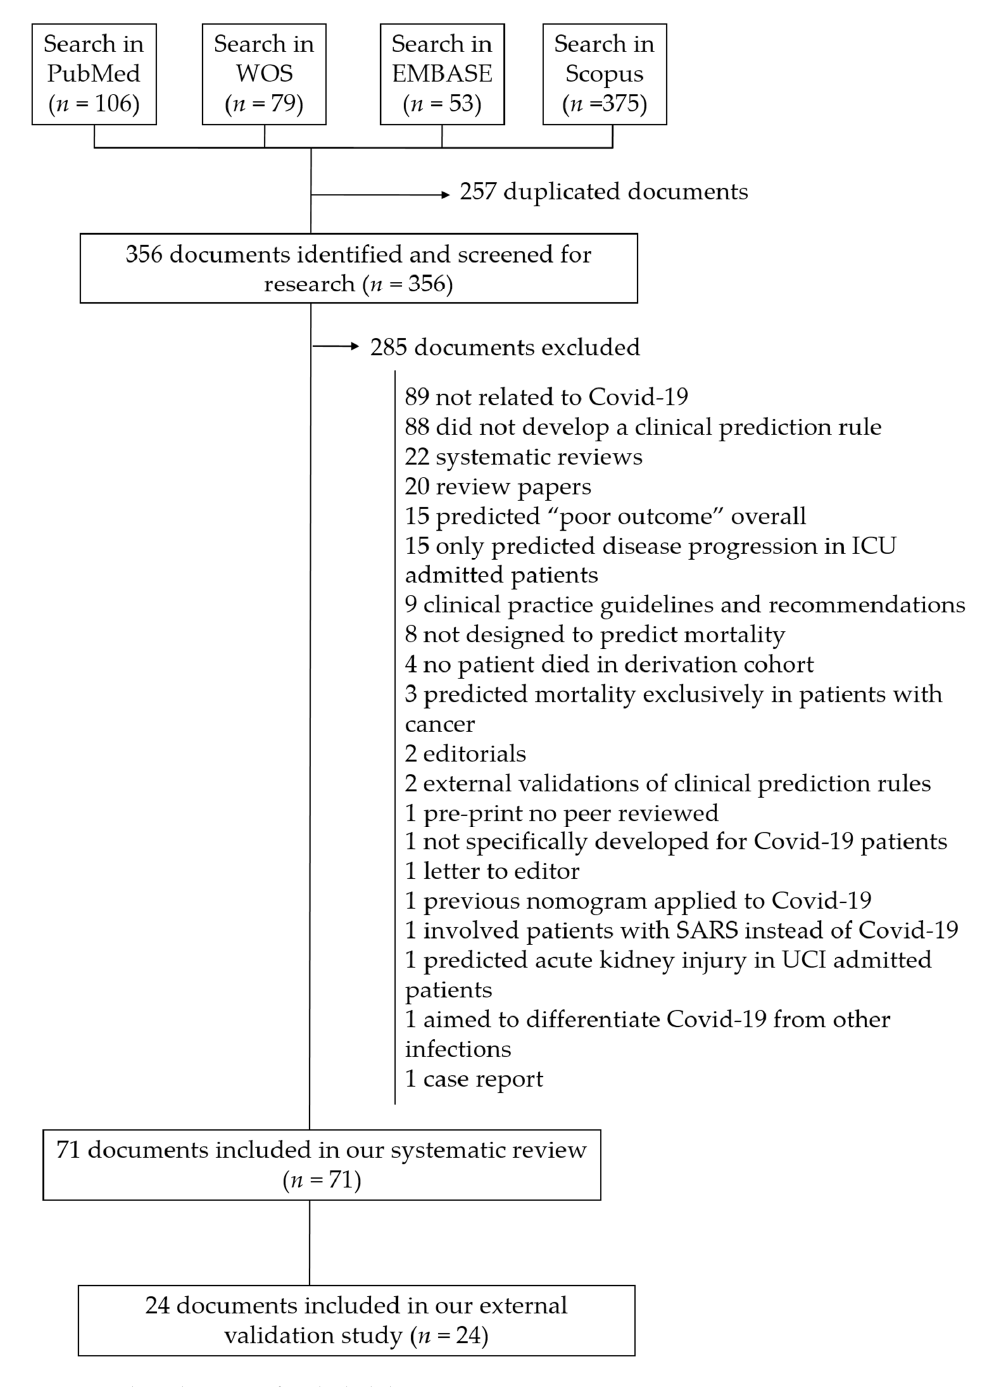
Figure 1. Flow diagram of included